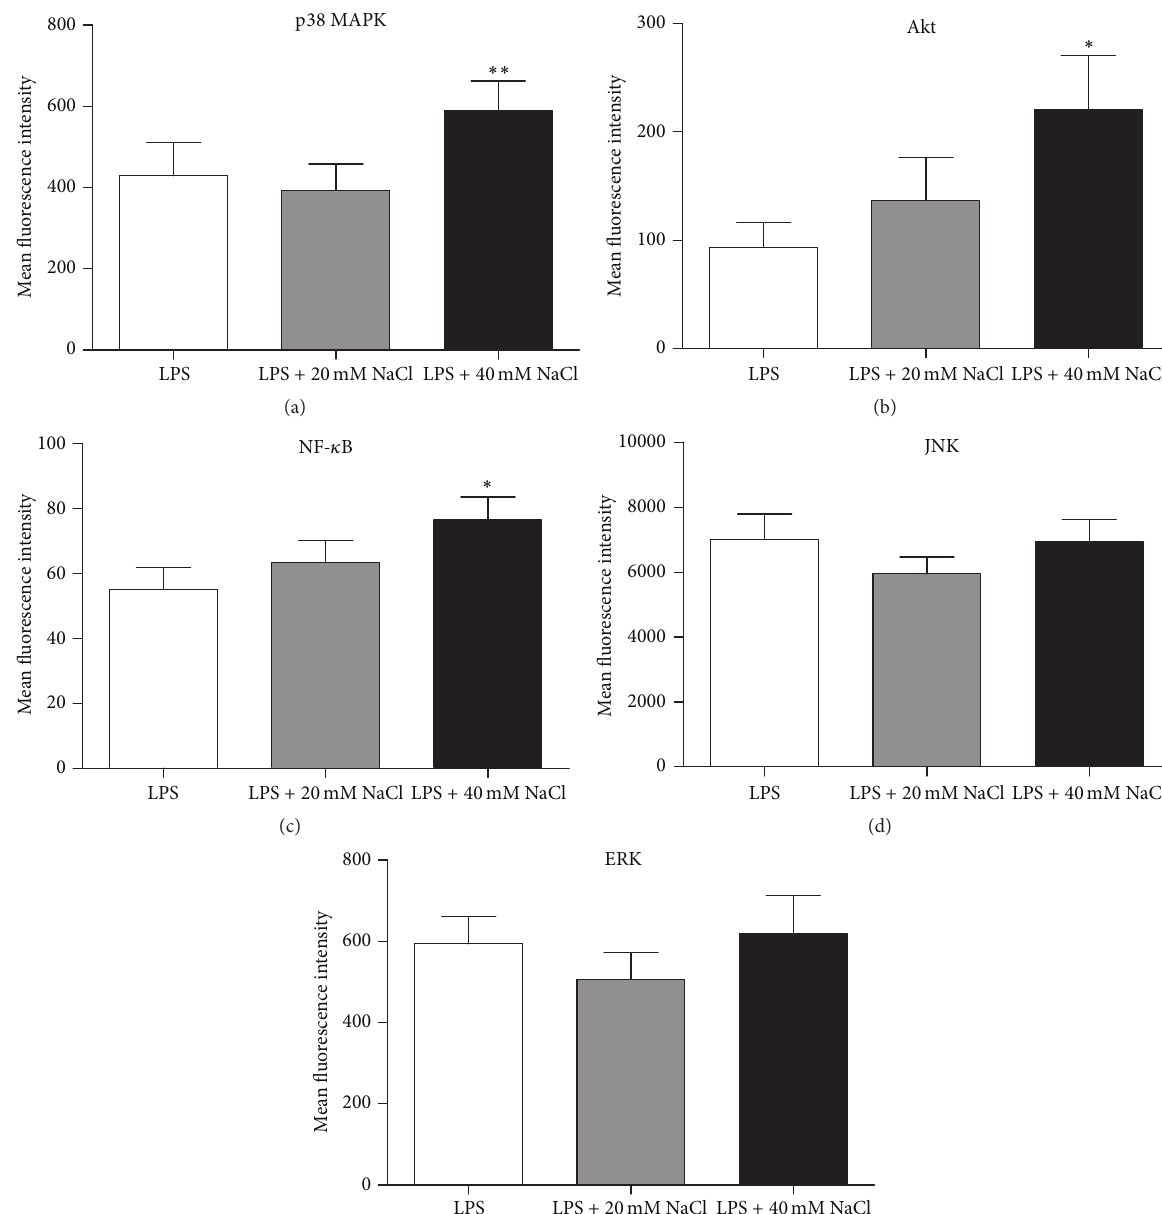
Figure 4: NaCl enhanced the phosphorylation of p38 MAPK, Akt, and NF- 𝜅 B but had no influence on the phosphorylation of JNK and ERK1/2 in ARPE-19 cells. ARPE-19 cells were cultured with LPS and different additions (20mM or 40 mM) of NaCl for 20 min. The levels of intracellular phosphorylated signaling molecules in permeabilized ARPE-19 cells were measured by flow cytometry. The data showed the MFI of p38 MAPK ((a) 𝑛 = 7 ), Akt ((b) 𝑛 = 8 ), NF- 𝜅 B ((c) 𝑛 = 13 ), JNK ((d) 𝑛 = 10 ), and ERK1/2 ((e) 𝑛 = 7 ). The results are expressed as mean fluorescence intensity (MFI) ± SD of three independent experiments. ∗ 𝑃 < 0.05 and ∗∗ 𝑃 < 0.01 compared to the control. All results are analyzed following three separate experiments. Paired-samples t -test (when the difference between the two tested groups conforms to normal distribution) or Wilcoxon matched-pairs test (when the difference between the two tested groups does not conform to normal distribution) was used for statistical analyses for LPS control versus LPS + 20 mM NaCl or LPS + 40 mM NaCl in each group.